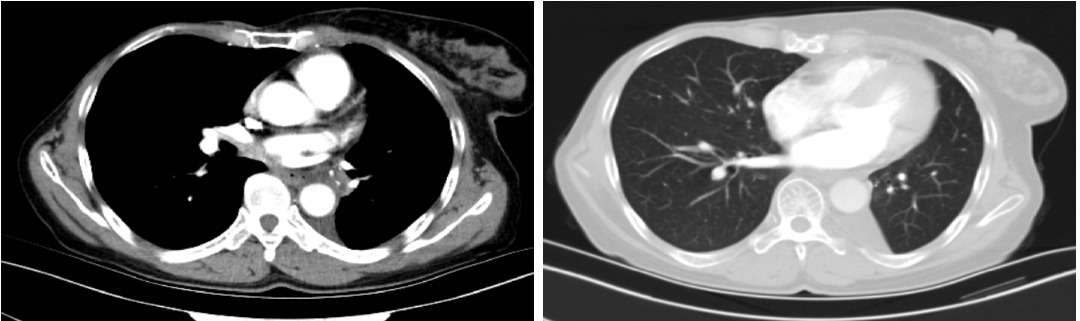
Figure 4. A follow-up CT scan revealed postoperative changes with no evidence of disease recurrence.